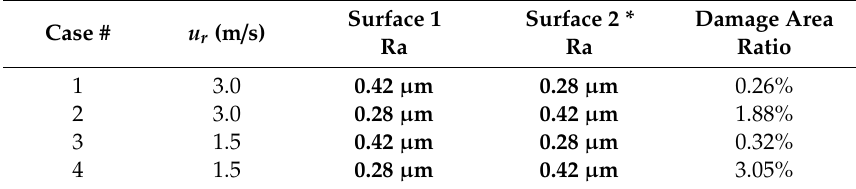
Table 2. Four cases of di ff erent roughness and